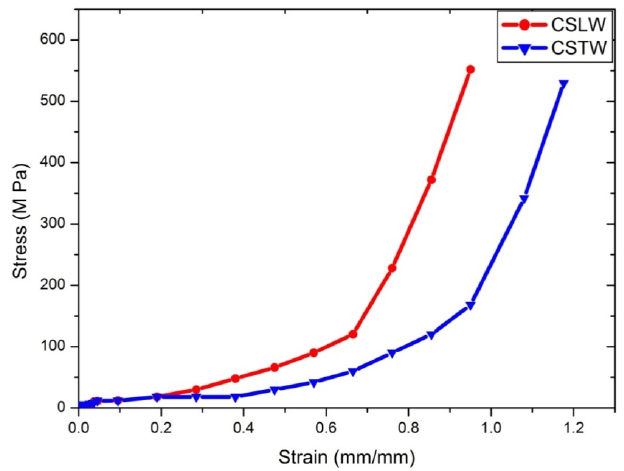
Figure 12. Compression stress–strain curve for wet